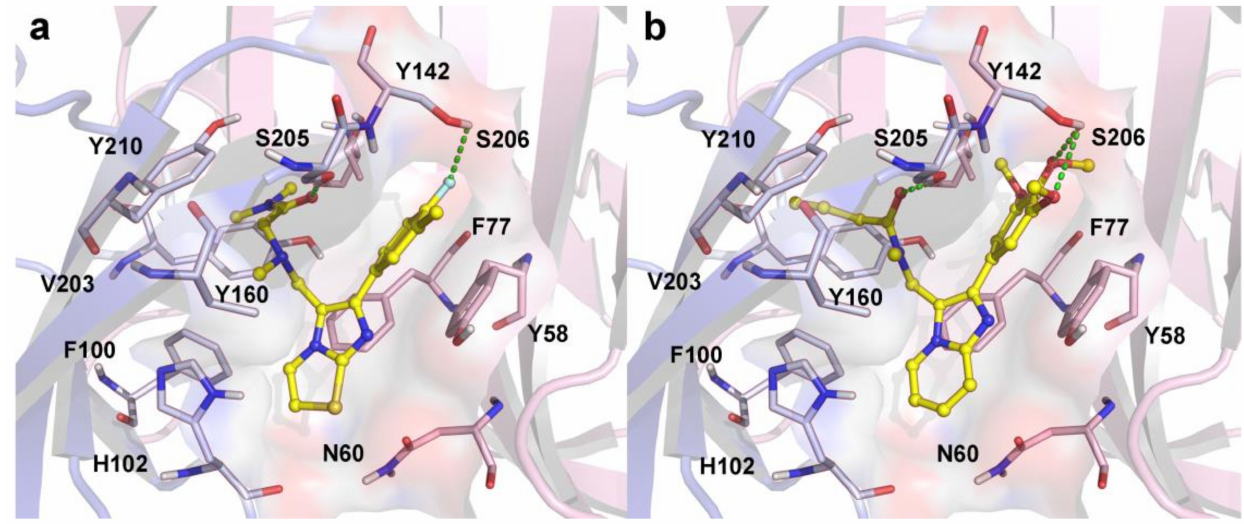
Figure 12. The docking results of the newly screened compounds DS03 ( a ) and DS04 ( b ) in the binding site of human α 1 β 2 γ 2 GABA A R (PDB ID: